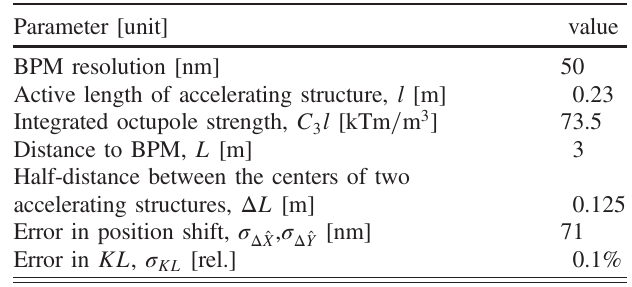
TABLE II. Assumed parameters and